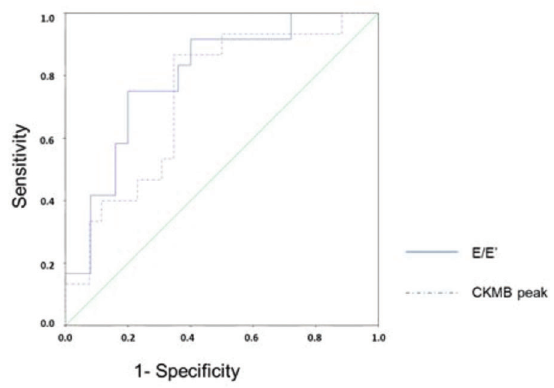
Figure 4 - ROC curve for predicting ventricular remodeling based on the E/E ’ ratio and CKMB peak. ROC, receiver-operating characteristics; E: transmitral flow peak velocity in early filling phase; E ’ : the speed of mitral annular diastolic excursion on tissue Doppler in the early filling phase; CKMB, creatinine kinase MB